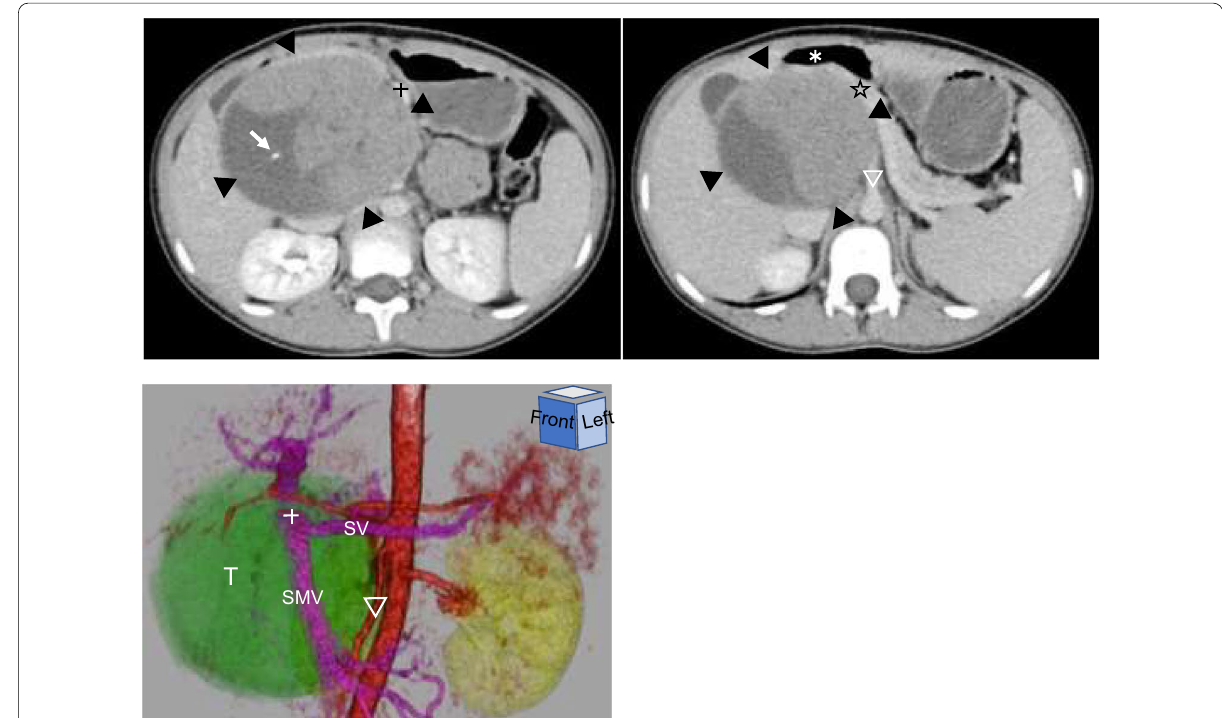
Fig. 1 Contrast-enhanced CT scan and 3D imaging on admission. The tumor is located in the retroperitoneum, including the pancreatic head, in such a way that the pancreas ( ☆ ) is ventralized, the duodenum ( ✻ ) is right ventralized, and the extrahepatic portal vein ( ventralized. The mass is well-defined, smooth, and covered with a thick coat-like structure (surrounded by ▼ ), with thin septum-like structures with microcalcification ( ) and papillary enhancing components within the tumor. In the 3D image from the left anterior view, the extrahepatic → portal vein ( ) runs ventrally to the left in contact with the tumor surface, and the SMA ( ▽ ) runs to the left in contact with the tumor surface. CT + computed tomography, SMV superior mesenteric vein, SV splenic vein, T tumor